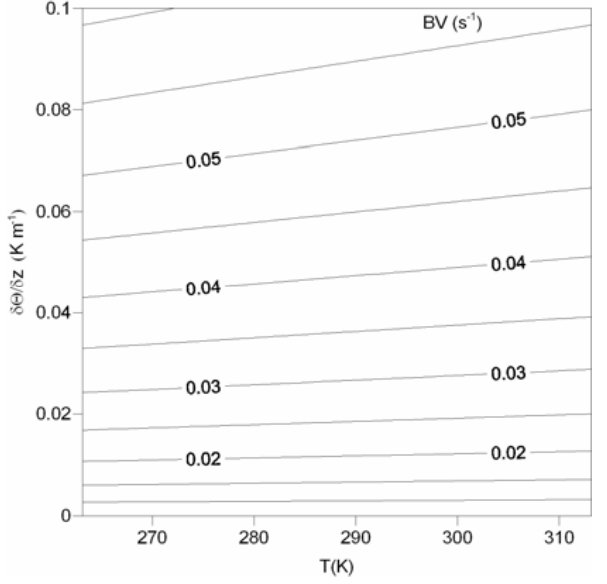
Fig. 1. BV behaviour for usual ranges of temperature and potential Fig. 2. L values for usual ranges of friction velocity and scale tem- Figure 1.- BV behaviour for usual ranges of temperature and potential temperature temperature gradient. Figure 2.- L values for usual ranges of friction velocity and scale temperature. gradient.